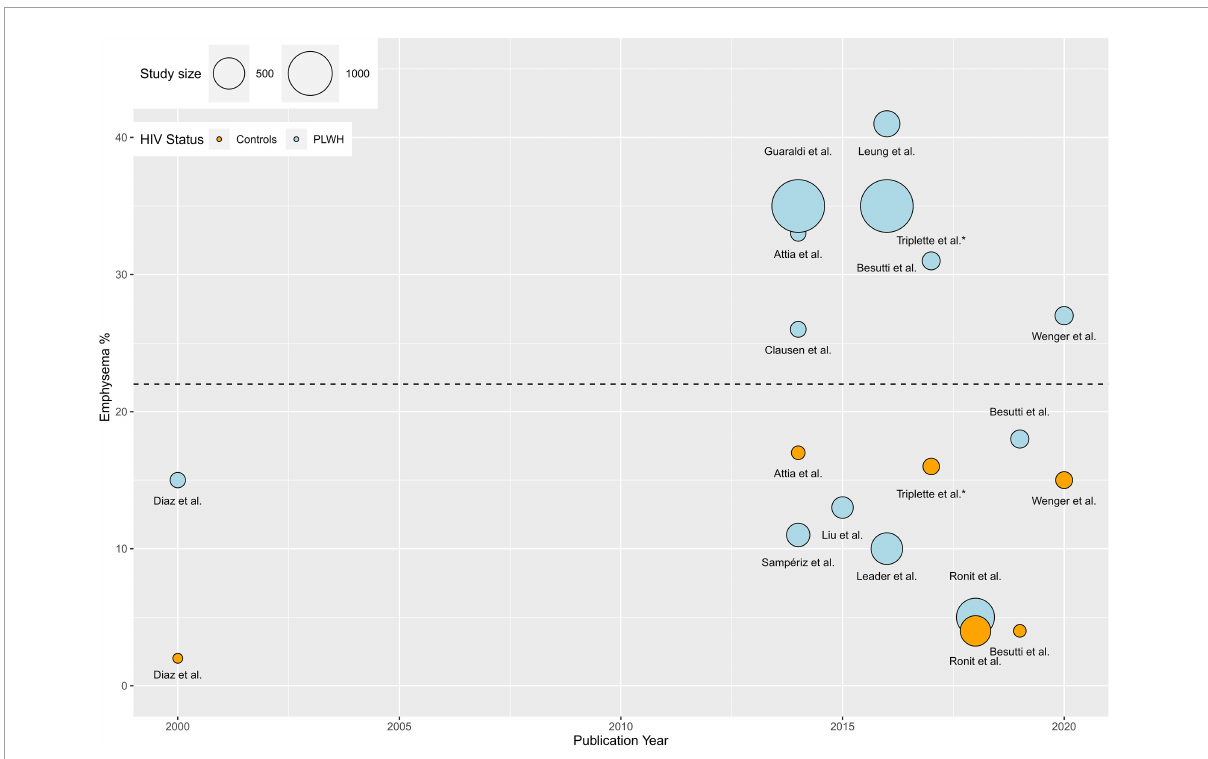
FIGURE2 Visual representation of prevalence in PLWH and controls. A visual presentation of the prevalence of emphysema in all the included studies is presented. The weighted average prevalence of emphysema was 23% (95% CI: 16–30) (Horizontal black dotted-line). Triplette et al. published four studies on emphysema prevalence with similar results (prevalence = 31–33% in all studies). Only one of the four studies is shown in the plot for simplicity. The study by Maitre et al. (7) was register-based and included 10,067 hospitalized PLWH and 8,244,682 hospitalized non-HIV controls, and it did not include a definition of emphysema. Therefore, the study by Maitre et al. (7) differed substantially from the others in its study design, population size, and estimations. Lack of emphysema definition prohibits comparison with other studies. Furthermore, including this study in the analyses would cause bias in estimations, and we chose to exclude this study from the